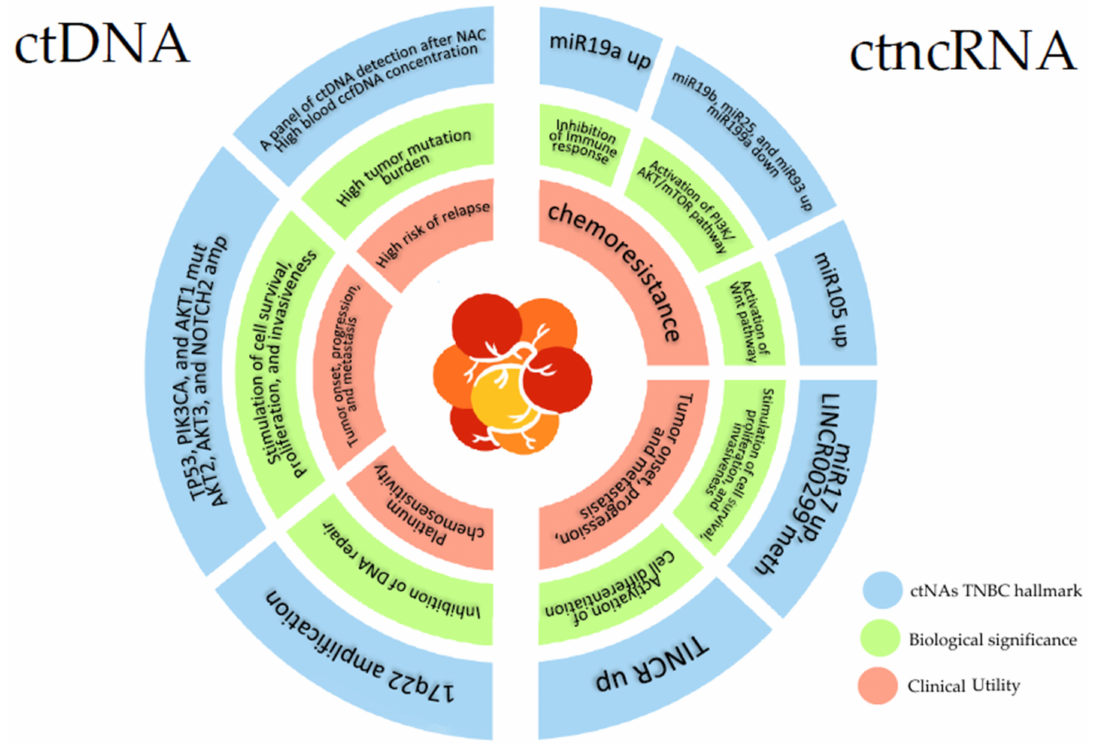
Figure 2. Schematic representation of the main ctNAs TNBC hallmarks described in this review.